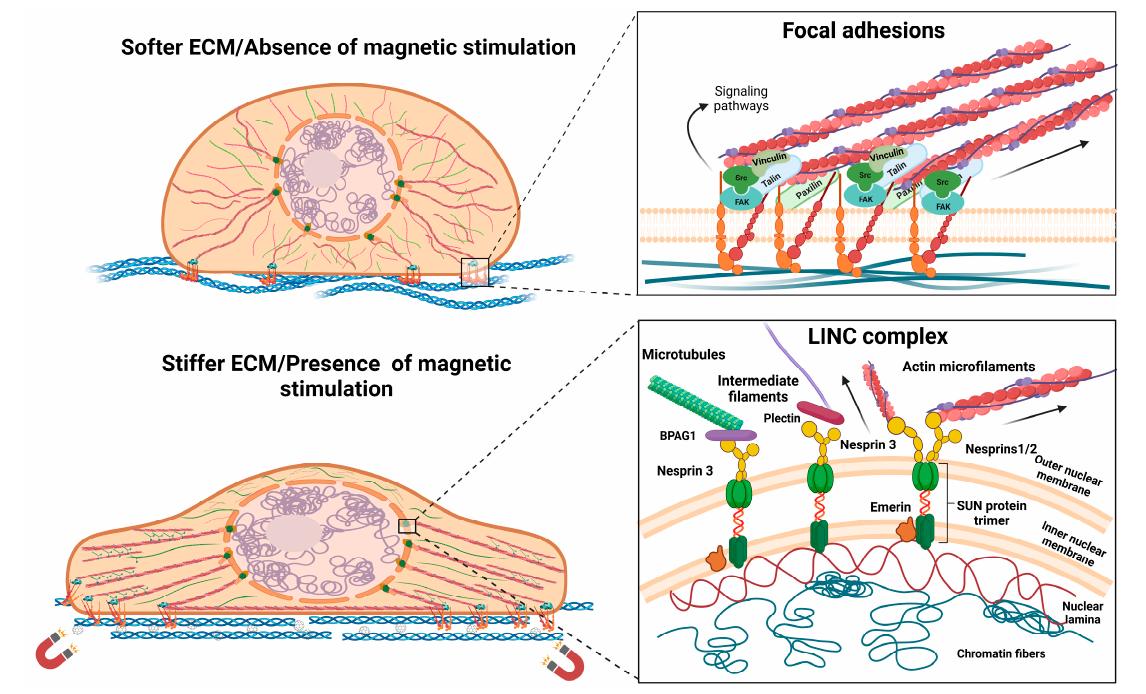
Figure 1. Morphological changes after interaction with magnetic materials and magnetic stimula- tion, representing the focal adhesion–cytoskeleton–nuclear membrane axis. Abbreviations: bullous pemphigoid antigen—BPAG1; extracellular matrix—ECM; focal adhesion kinase—FAK; linker of nucleoskeleton and cytoskeleton—LINC; Sad/UNC84—SUN domain proteins. Image was created with BioRender.com.